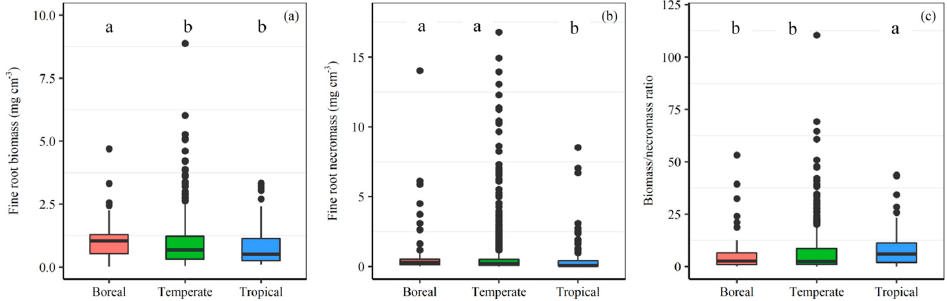
Figure 1. Monthly fine root biomass ( a ), necromass ( b ) and their biomass / necromass ratio ( c ) among boreal, temperate and tropical forests.